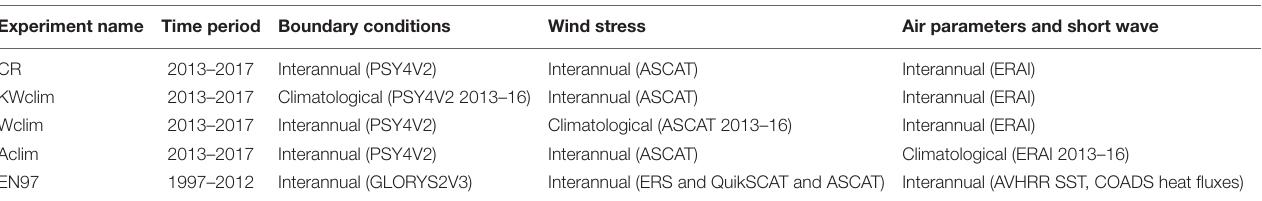
FIGURE 2 | ASCAT monthly mean wind stress anomalies (in N m − 2 ) in 2017: (A) January, (B) February, (C) March. Anomalies were computed with respect to a climatology over 2013–2016. (D) Mean Ekman pumping velocity anomaly (in m day − 1 , positive upward) in February-March 2017. (E) Ekman pumping velocity (in m day − 1 , positive upward) in a coastal box (4–10 ◦ S, 0–200 km) from the coast, see red box in (D) . (F) Alongshore wind stress in a coastal box (4–10 ◦ S, 0–100 km) from the coast, see red box in (A) . The alongshore direction was the mean orientation of the coastline between 6 ◦ S and 10 ◦ S. Red and dashed lines mark climatological (over 2013–2016) and monthly mean values, respectively. TABLE 1 | Name and characteristics of the CROCO regional